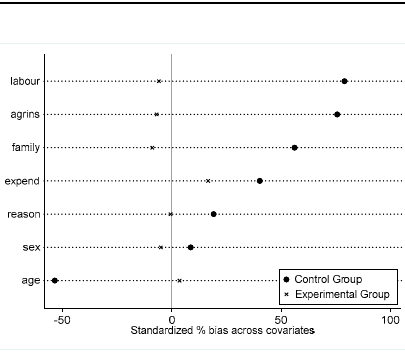
Figure 1. Standard deviation of the covariates before and after matching.